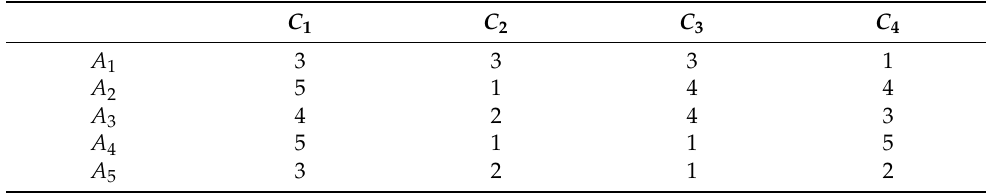
Table 4. The second of four selected initial decision-making matrices.